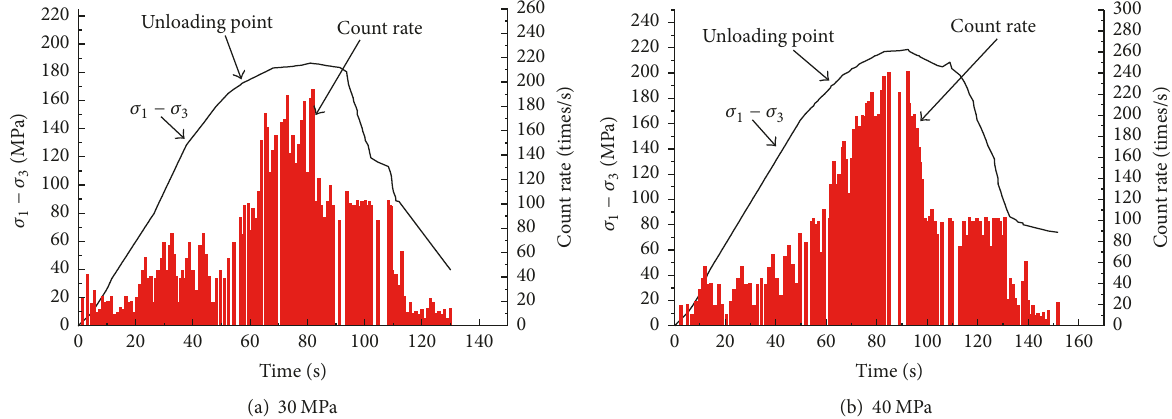
Figure 5: Curves of axial stress difference and count rate with time in sandstone failure process under various confining pressures in